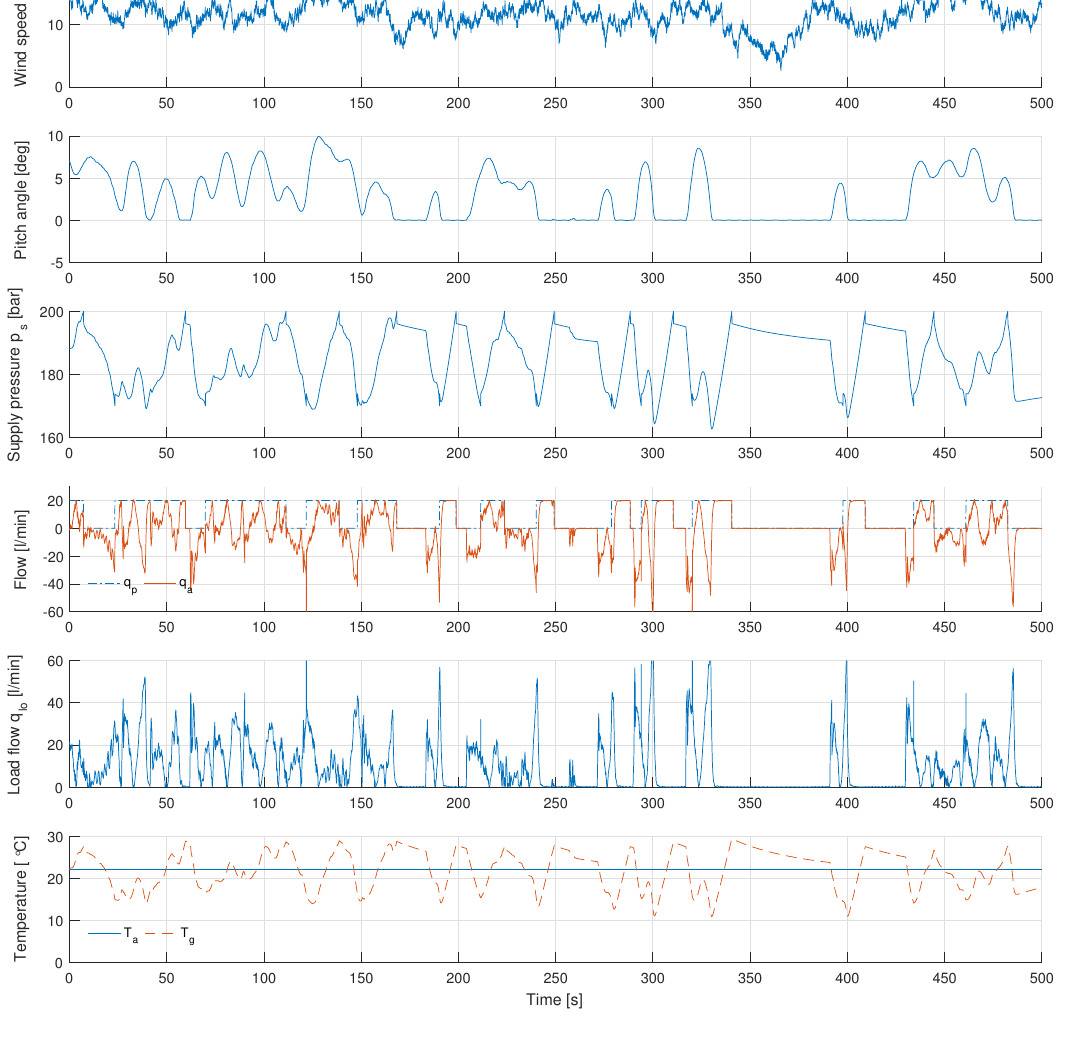
Figure 2. Simulated wind speed, pitch angle and accumulator states for nominal operating condition. The accumulator is pre-charged with 100 bar. External leakage is set to